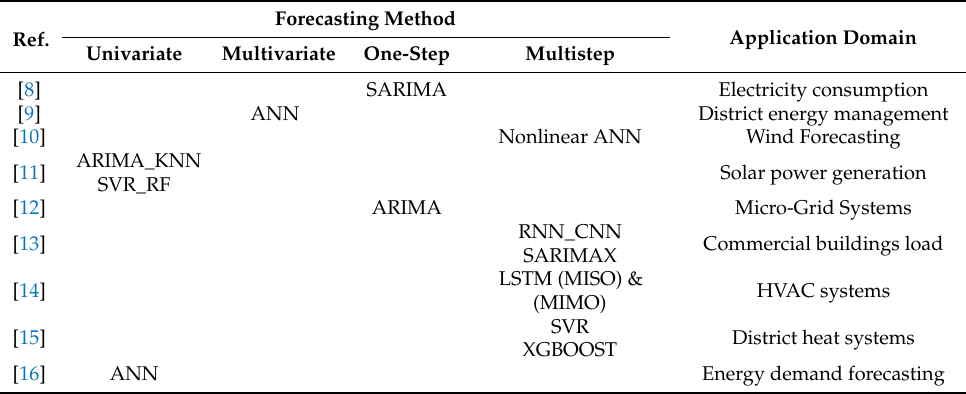
Table 1. Forecasting methods for different application domains.